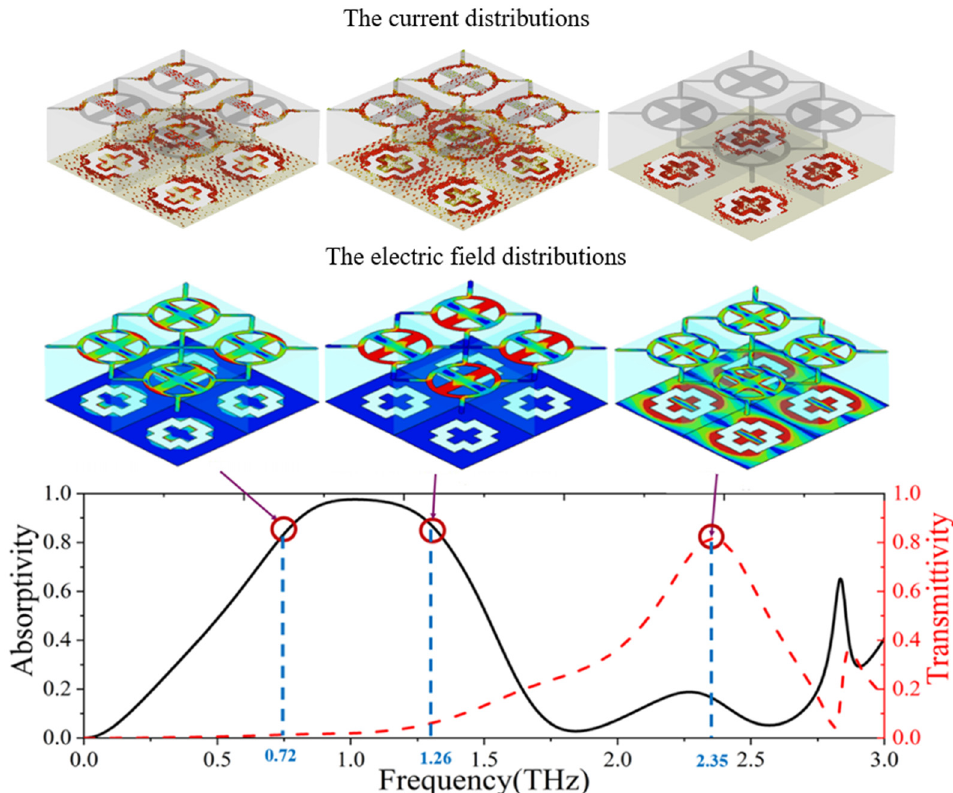
Figure 8. The current distribution and the electric field distribution of the graphene tunable metamaterial at three key frequency points.